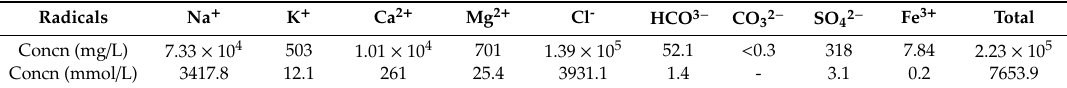
Table 1. Composition and concentration of ions in formation water from the Tahe